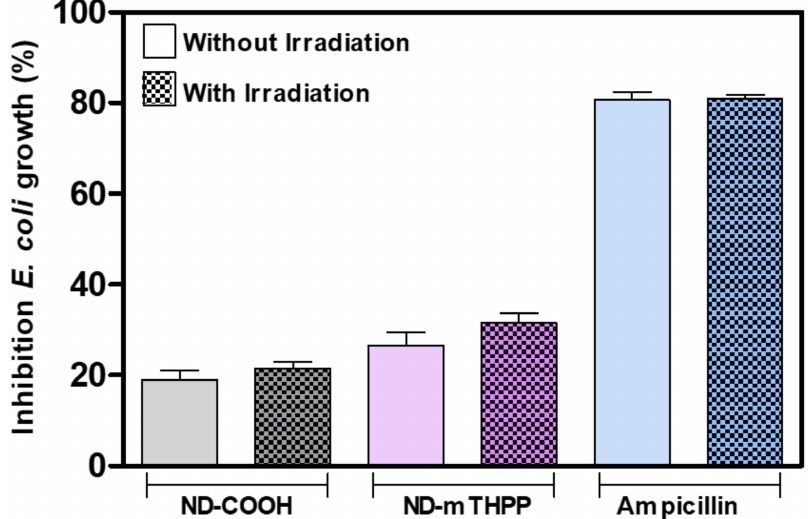
Figure 4. Percentage of inhibition of Escherichia coli growth calculated by considering OD 600 of E. coli grown in the absence of sample and irradiation as 100% of growth. E. coli was incubated with ND-COOH (100 µ g/mL), ND-mTHPP (100 µ g/mL) and ampicilin (100 µ g/mL), in Mueller Hinton Broth Medium (MHB) for 24 h, with and without irradiation (660 nm; 51 J/cm 2 ). Experiments were repeated in triplicate and all the values were statistically different ( p < 0.001) in comparison with control group of E. coli growth (without sample and in the absence of